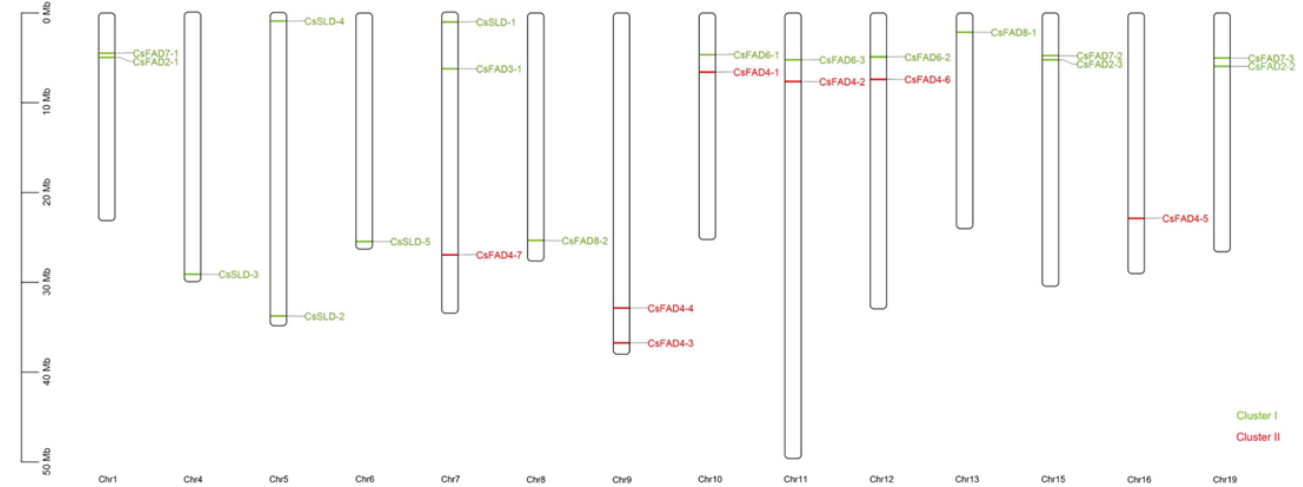
Figure 3. TBtools was used to draw the maps of chromosome location. Uneven distribution of CsFAD genes on 14 chromosomes. Cluster I represent fatty acid desaturase (FAD) that can catalyze cis -double-bond fatty acids. Cluster II represents fatty acid desaturase (FAD) that can catalyze trans -double-bond fatty acids.